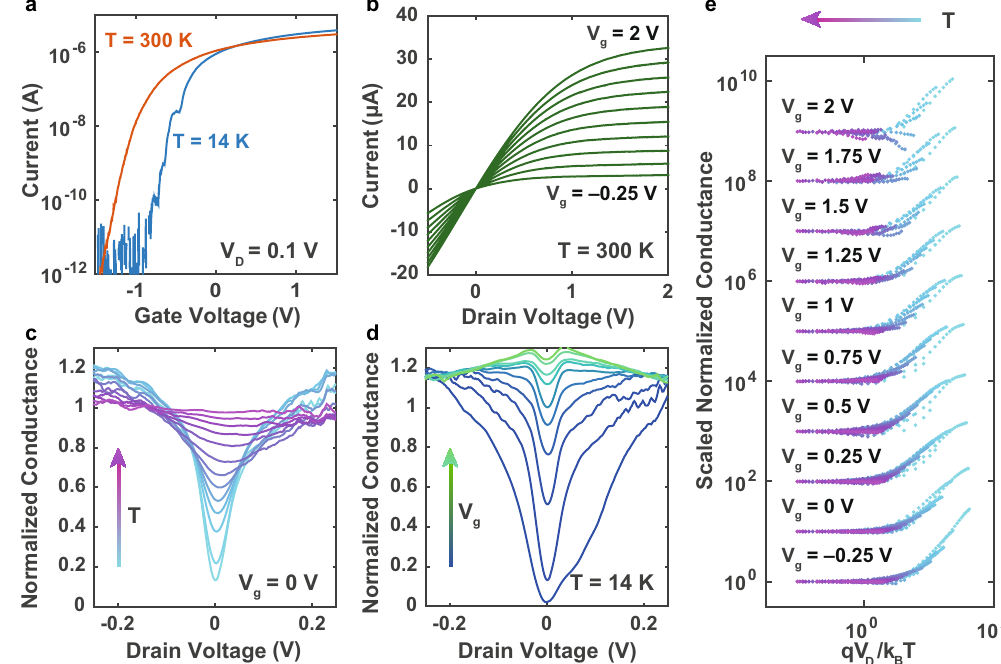
Figure 3. Universal conductance scaling. ( a ) The drain current versus gate voltage measured in the high- temperature ( T = 300 K) and low-temperature ( T = 14 K) regimes. In the low-temperature regime Coulomb blockade oscillations can be observed below the threshold voltage V th ≈ − 0.25 V. ( b ) Room temperature current versus drain voltage ( I − V b ) traces are measured as a function of gate voltage. The I − V D traces exhibit the typical transistor behaviour where the current I ∝ ( V g − V th ) V D − V D 2 /2 in the linear region ( V D < V g − V th ) and weakly dependent on V D in the saturation region ( V D ≥ V g − V th ). ( c ) The normalized conductance (to 300 K) versus drain voltage as a function of temperature. There is a temperature dependent suppression of the conductance around zero bias which is superimposed onto the voltage dependent conductance. Normalizing the conductance by dividing it by the room temperature conductance results in a symmetric conductance gap centred around zero drain bias. ( d ) The normalized conductance versus drain bias voltage as a function of gate voltage. With increasing gate voltage, and carrier density, the conductance gap around zero drain bias gets softer, indicating enhanced screening of the Coulomb interaction between localized electrons. ( e ) A universal scaling plot of the conductance data, using a T -renormalized energy scale qV D / k B T as described in Supplementary Information section I. All conductance traces for each gate voltage coincide, showing universal conductance scaling over a large gate range. The curves are scaled for each gate voltage and offset for